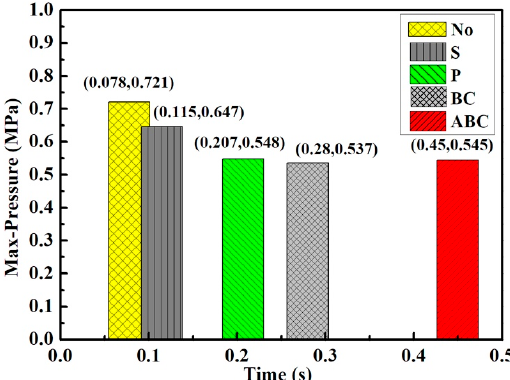
Figure 8. The comparison of the max-pressure and the time reach the max-pressure with different powders. Table 1. The explosion parameters of methane-air premixed gas with different powders. Sample